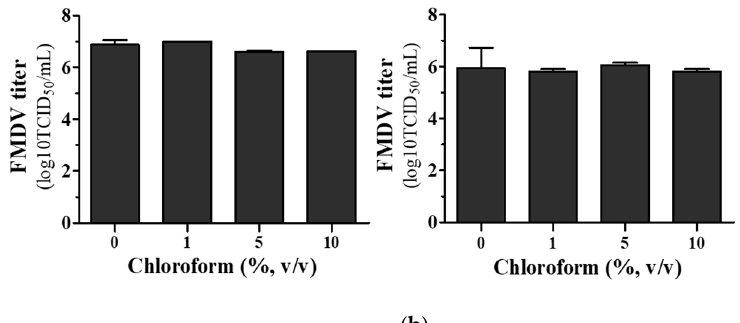
Figure 1. Effect of chloroform treatment on viral proteins of FMD virus (FMDV). ( a ) The O/Boeun/SKR/2017 and O/Andong/SKR/2010 virus culture supernatants were treated with various concentrations of chloroform (upper panel) and trichloroethylene (lower panel). The structural (VP1) and non-structural (3AB) proteins were detected by Western blot analysis using anti-FMDV type O VP1 and 3B monoclonal antibodies. ( b ) The O/Boeun/SKR/2017 (left panel) and O/Andong/SKR/2010 (right panel) virus culture supernatants were treated with various concentrations of chloroform. Viral titers were determined on baby hamster kidney-21 (BHK-21) cells, and the titers were expressed as log10 TCID 50 per milliliter. All experiments were performed in duplicate.